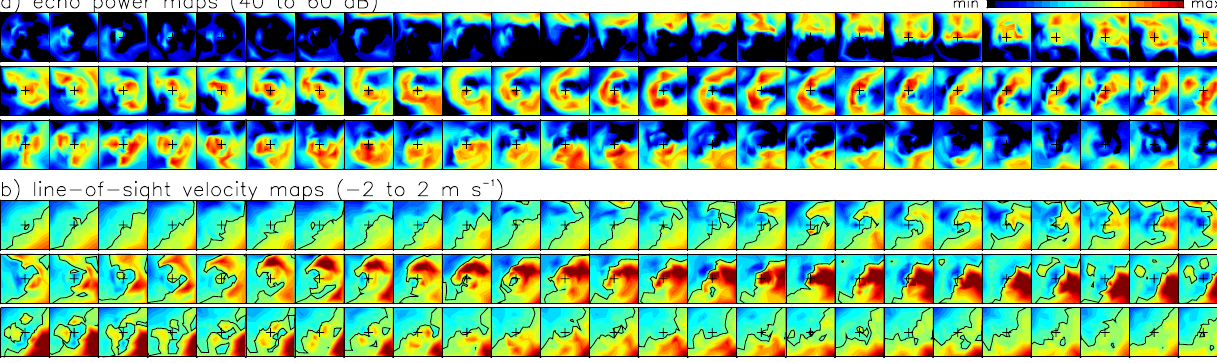
Fig. 6. Horizontal slices of clear-air (a) echo power and (b) line-of-sight velocity, 1.425km AGL, starting 09:56 JST 27 August 2001 as a convective cell moves across. Zero wind contour is overplotted in (b). Time step is 6.55s starting at top-left corner, north is at the top of each 700 × 700m slice and + marks zenith.